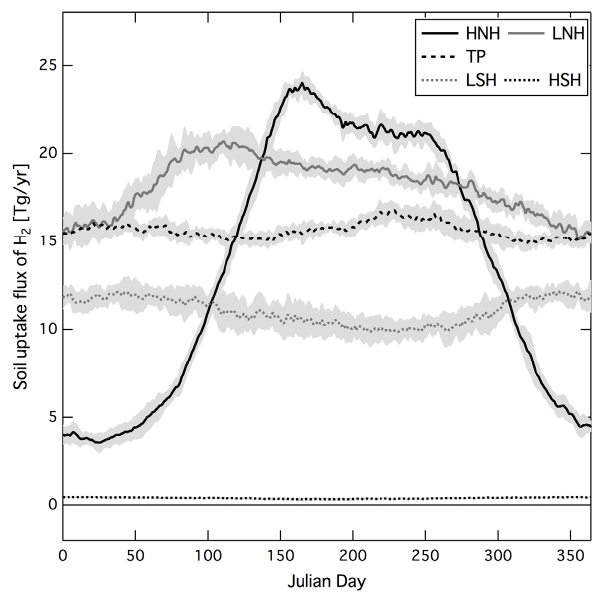
Fig. 2. Seasonal variations of soil uptake flux [Tgyr − 1 ] for the lat- Fig. 2 Seasonal variations of soil uptake flux [Tg yr -1 ] for the latitudinal range itudinal range north of 45 ◦ N (HNH), 45 ◦ N to 15 ◦ N (LNH), 15 ◦ N to 15 ◦ S (TP), 15 ◦ S to 45 ◦ S (LSH), and south of 45 ◦ S (HSH). north of 45°N (HNH), 45°N to 15°N (LNH), 15°N to 15°S (TP), 15°S to Shaded areas are the standard deviation for the multi-year aver- age, which arise from both the day-to-day variation and inter-annual 45°S (LSH), and south of 45°S (HSH). Shaded areas are the standard variation of the deviation for the multi-year average, which arise from both the day-to-day variation and inter-annual variation of the flux.